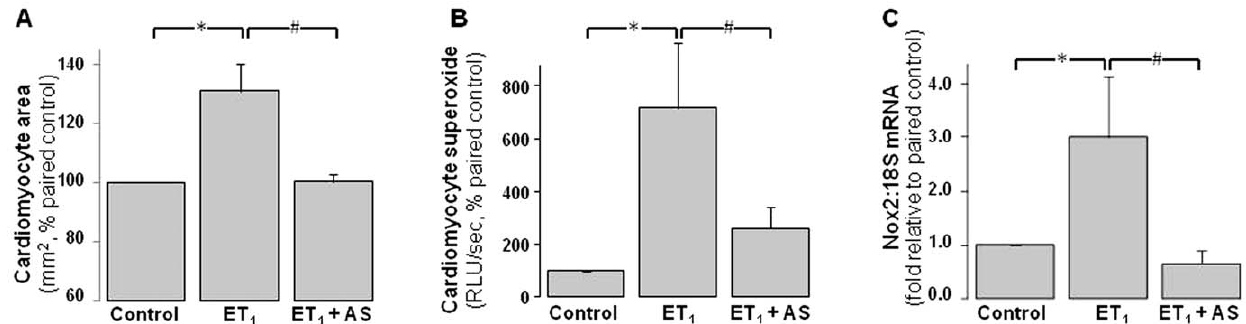
Figure 5. Angeli’s salt also blunts endothelin-1 (ET 1 )-induced cardiomyocyte responses. AS (1 m mol/L, added 4 6 /day over 48 h) inhibits ET 1 (60 nmol/L)-stimulated actions in neonatal cardiomyocytes. This is evident on A cardiomyocyte area (n=3 myocyte preparations); B cardiomyocyte NADPH oxidase activity, on ET 1 -induced superoxide generation (lucigenin chemiluminescence, n=7 myocyte preparations); and C cardiomyocyte Nox2 NADPH oxidase gene expression, induced by ET 1 (n=4 myocyte preparations). *P , 0.05 vs control; # P , 0.05 vs ET 1 alone.